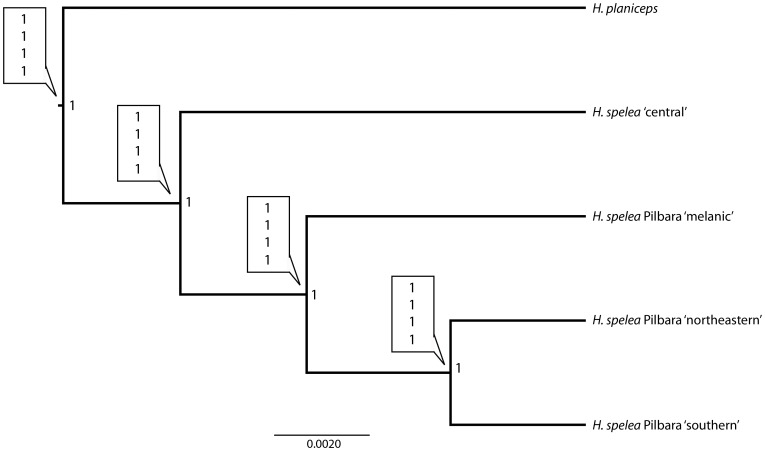
Species tree estimation and Bayesian species delimitation results.Each node of the tree is labeled with the posterior probability obtained from the *BEAST analysis (outside the box) and the posterior probabilities of the species split estimated using the rjMCMC under different combinations of prior distributions of θ and τ (inside the box) in the order: 1 – prior means = 0.1; 2 – prior means = 0.001; 3 – prior mean θ = 0.1, prior mean τ = 0.001; 4 – prior mean θ = 0.04, prior mean τ = 0.175.